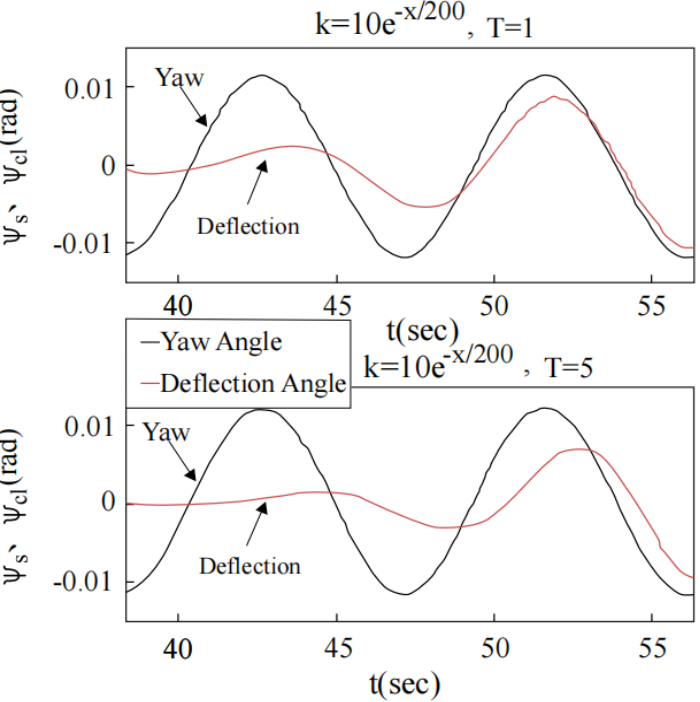
Figure 42. Tracking response curves of measurement axis under inertial tracking strategies with different T values.